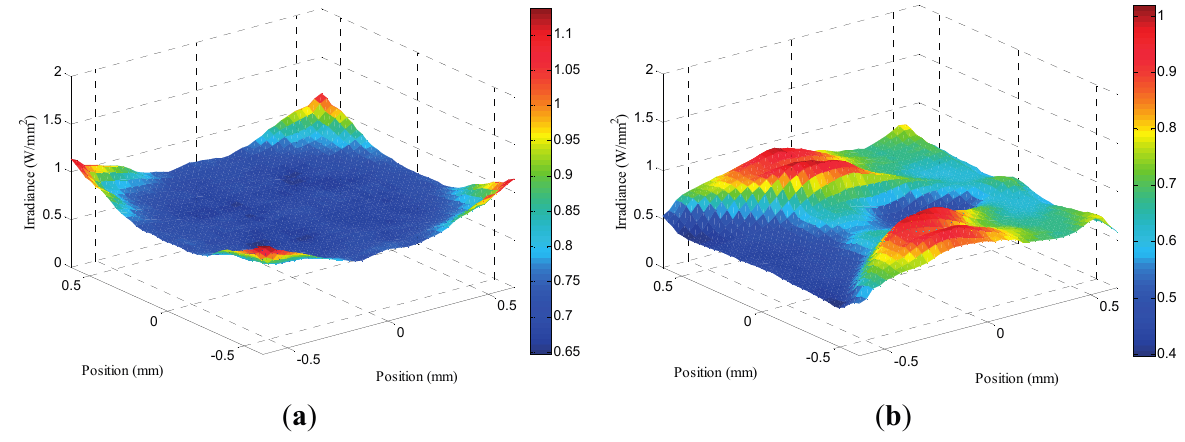
Figure 14. Irradiance distribution on the receiver for the Fresnel lens with KOD II-type SOE ( a ) under normal incidence; ( b ) incidence angle = 1.7°.